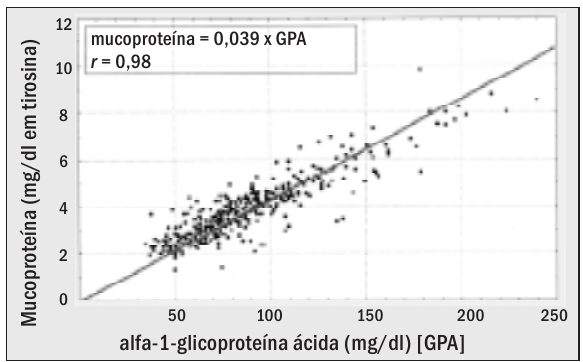
Figura 3 – Análise de regressão linear entre alfa-1-glicoproteína ácida (GPA) e mucoproteína expressa em tirosina quando o intercepto foi ajustado a zero. O coeficiente de correlação ( r ) e a equação de regressão encontram-se em